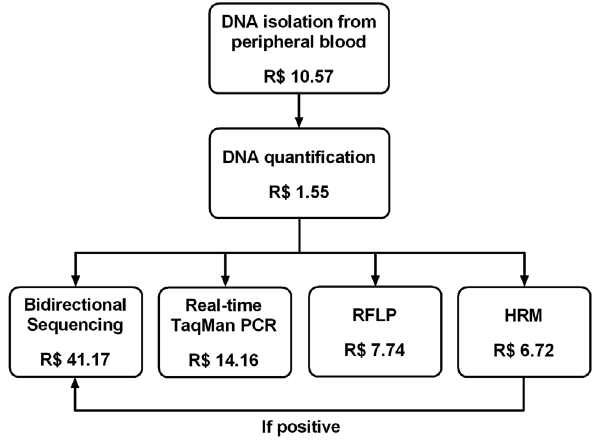
Figure 1 - Costs of each analytical step of TP53 -p.R337H genotyping by different methods for one